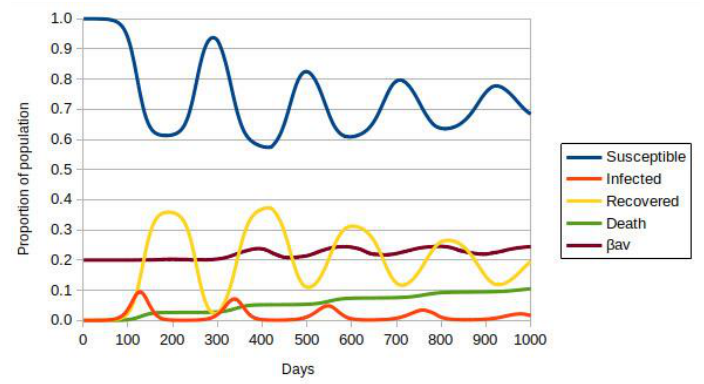
Figure 3. ABM-SIR dynamic of COVID-19 (i.e., Susceptible-Infected-Recovered Agent-Based model) evolution over 1000 days for social isolation of 40%, adjusted for the initial population of ∼ 8.75 × 10 5 individuals. Each color represents a population group, defined in the legend. The value of β av is the average for all infected people. The vaccination rate is 1/1000 of susceptible or recovered individuals per day.